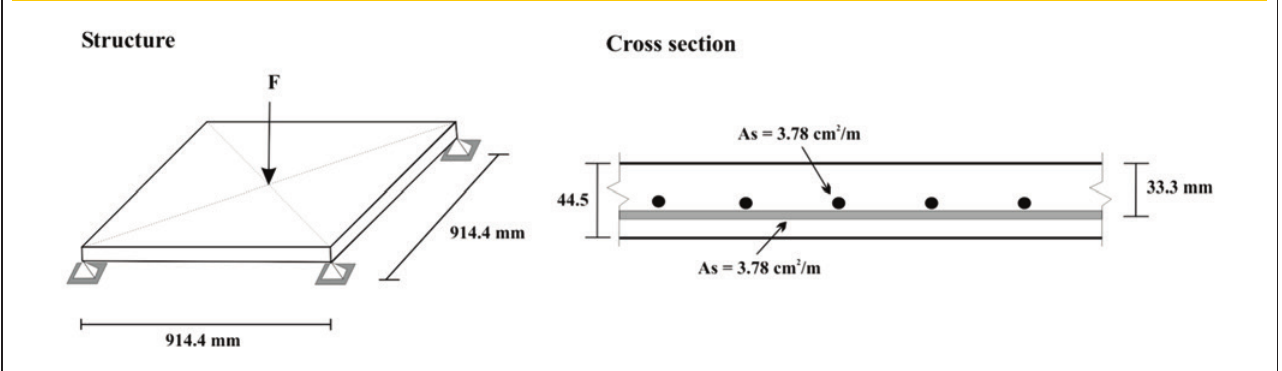
Figure 11 – Geometry and structure of slab supported by its four corners according to [37]